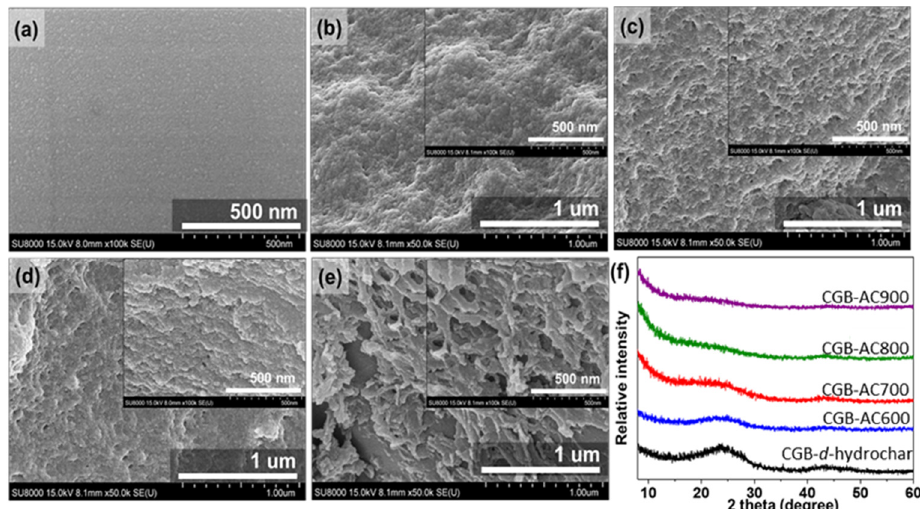
Figure 1. SEM images of ( a ) CGB- d -hydrochar and ( b – e ) CGB-AC samples at different activation temperatures (( b ): 600 °C, ( c ): 700 °C, ( d ): 800 °C, and ( e ): 900 °C), and ( f ) XRD patterns for the obtained samples.